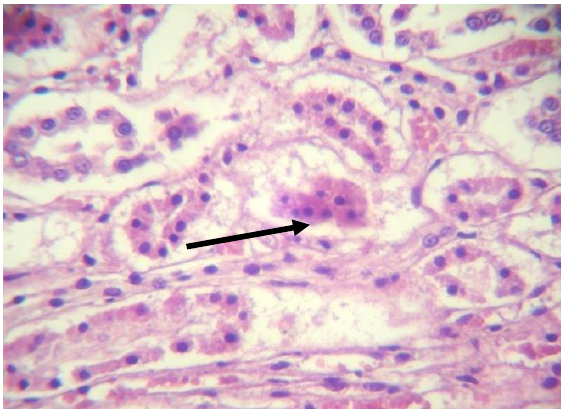
Fig 16: Microscopic section kidney from 1st immunized group at 3 days post challenge show slight sloughing of epithelial lining of tubules m (H&E X20).